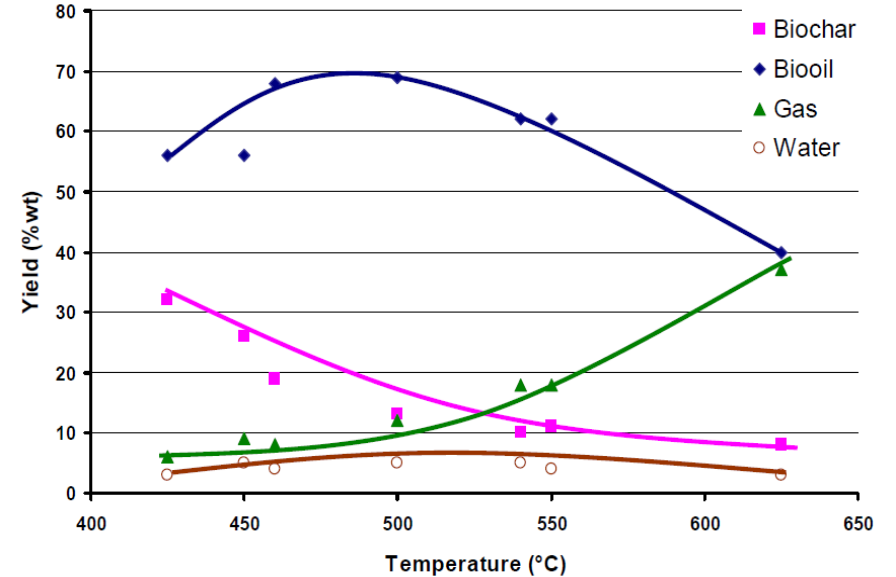
Figure 2. Relative proportions of end products in pyrolysis of biomass